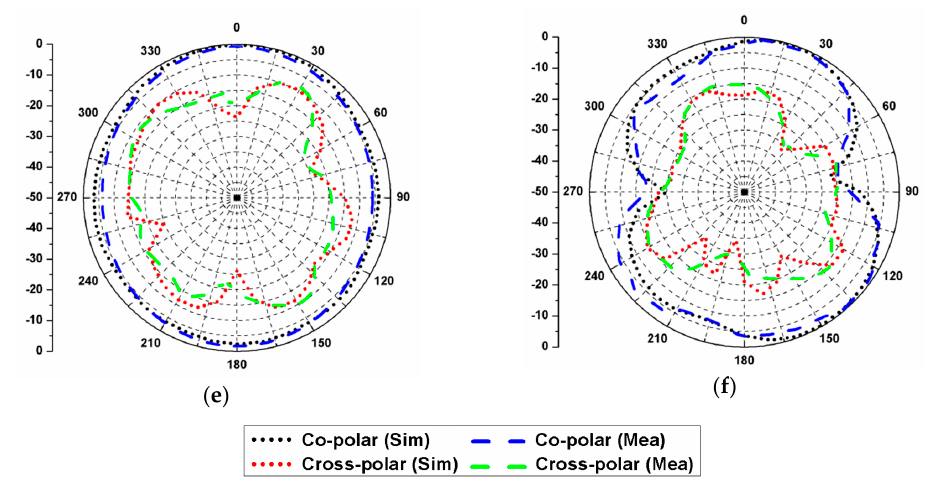
Figure 11. Radiation patterns of the proposed quad band-notched SWB antenna: ( a ) H-plane / 3 GHz, ( b ) E-plane / 3 GHz, ( c ) H-plane / 12 GHz, ( d ) E-plane / 12 GHz, ( e ) H-plane / 21 GHz, ( f ) E-plane / 21 GHz.